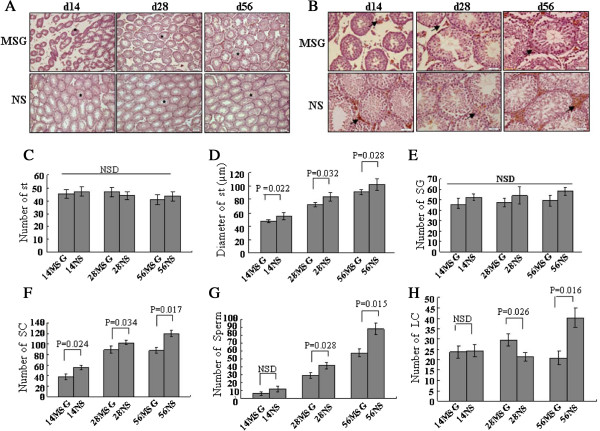
MSG treatment hindered the development of the testes. A and B are representative of the morphology of the seminiferous tubules (ST) of testes with IHC staining. Scale bar, 50 μm (A) and 3β-HSD positive Leydig cells with immunohistochemical staining. Scale bar, 20 μm (B). The positive cells were stained brown. The positive cells were cytoplasmic positive and membranous positive. In the middle and bottom panels are shown the average number of ST (C), the average diameter of ST (D) and the average number of 3β-HSD-positive Leydig cells per visual field (H). The numbers of spermatogonia (SG), spermatocytes (SC), and sperm per seminiferous tubule were counted separately (E, F, G). Star, seminiferous tubule; Arrow, 3β-HSD positive of Leydig cells; The means were compared using Student’s t-test. NSD, non-significant difference.